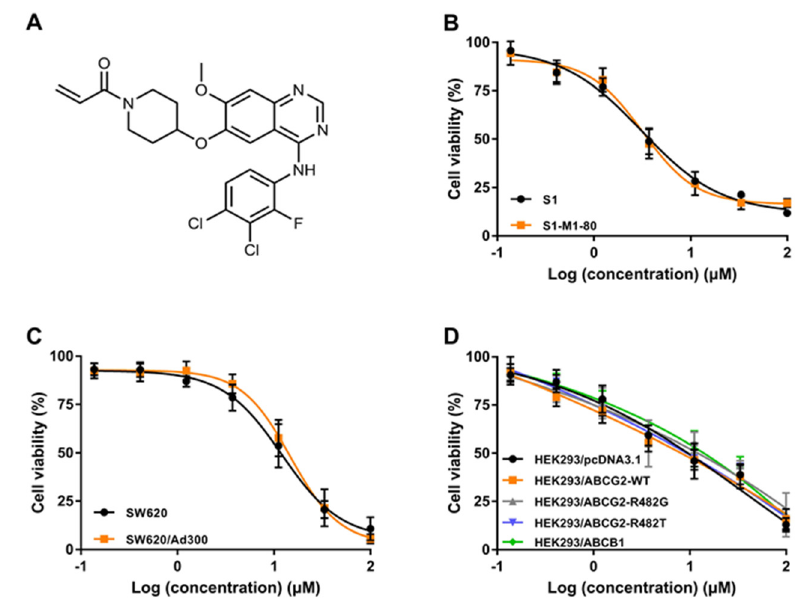
Figure 1. The cytotoxicity of poziotinib in parental and drug-resistant cell lines. ( A ) The chemical structure of poziotinib; cell viability curves for ( B ) S1 and S1-M1-80 colon cancer cells; ( C ) SW620 and SW620 / Ad300 colon cancer cells and ( D ) the transfected HEK293 / pcDNA3.1, HEK293 / ABCB1, HEK293 / ABCG2-WT, HEK293 / ABCG2-R482G and HEK293 / ABCG2-R482T cells. Data are expressed as mean ± SD based on data from three independent experiments.